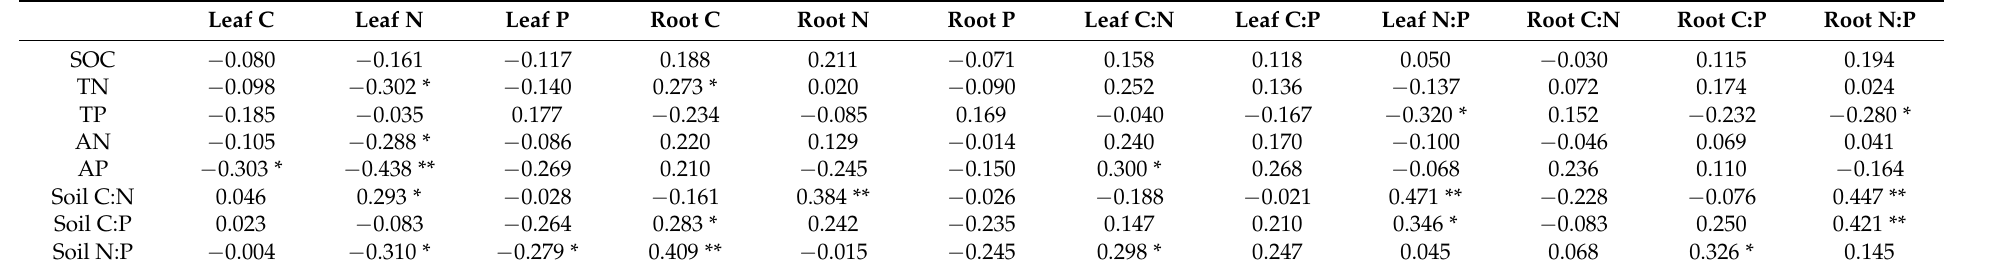
Table A4. Correlations and correlation probability between C, N, and P stoichiometry traits in karst shrubs and